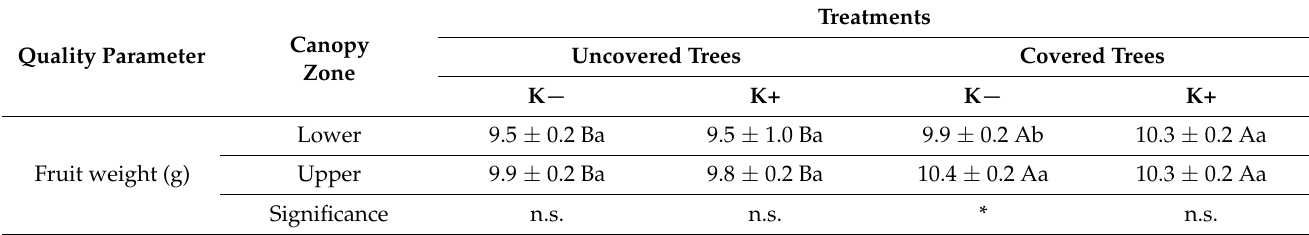
Table 1. Effects, at harvest, of two K spray treatments on the quality of sweet cherry (cv. Regina) fruits produced from covered and uncovered trees: conventional K regime (4 sprays during the season: K − treatment) or intensive K regime (7 sprays during the season: K+ treatment). Fruits from the upper and lower zone of the canopy were separately analyzed. The statistical significance between canopy zones for each treatment is also shown. Abbreviations: SSC (soluble solid content); TA (titratable acidity). Treatments Canopy Uncovered Trees Covered Trees Quality Parameter Zone Lower Fruit weight (g)